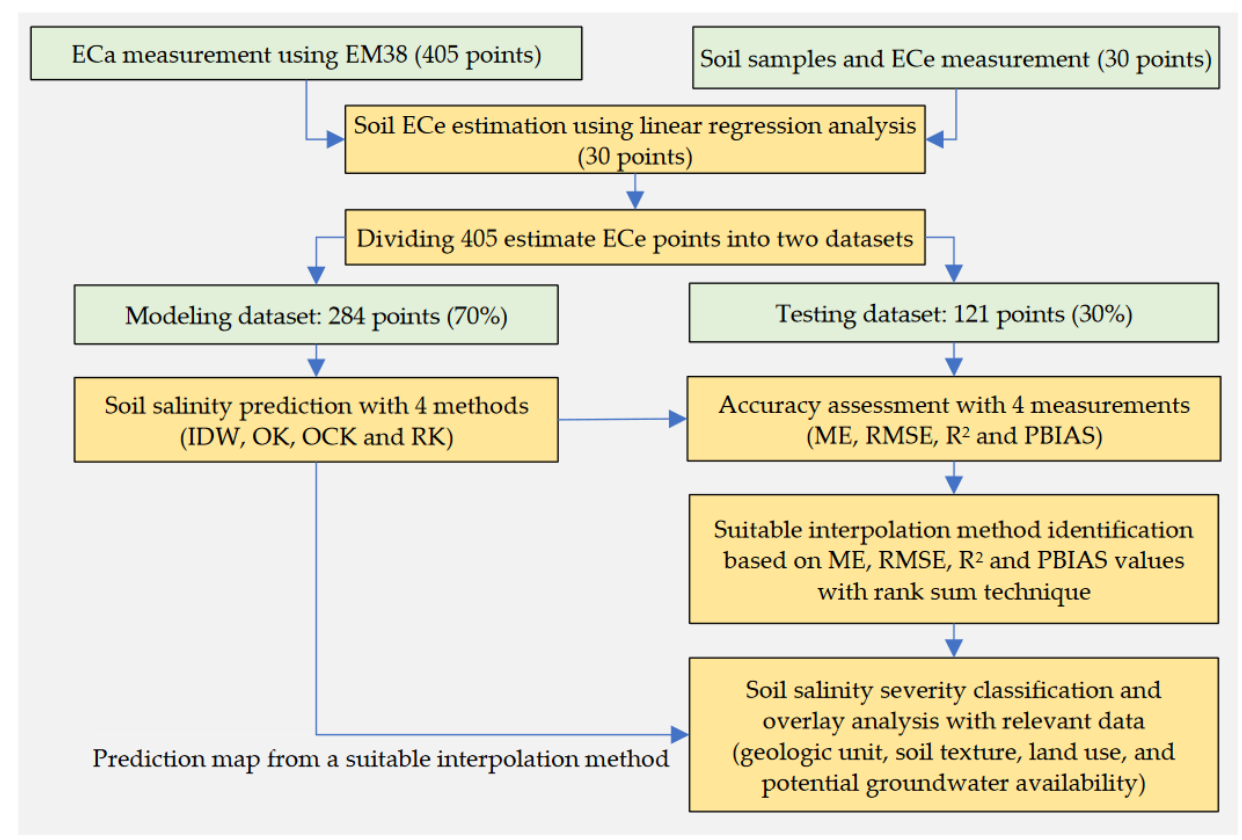
Figure 3. Workflow of research methodology.